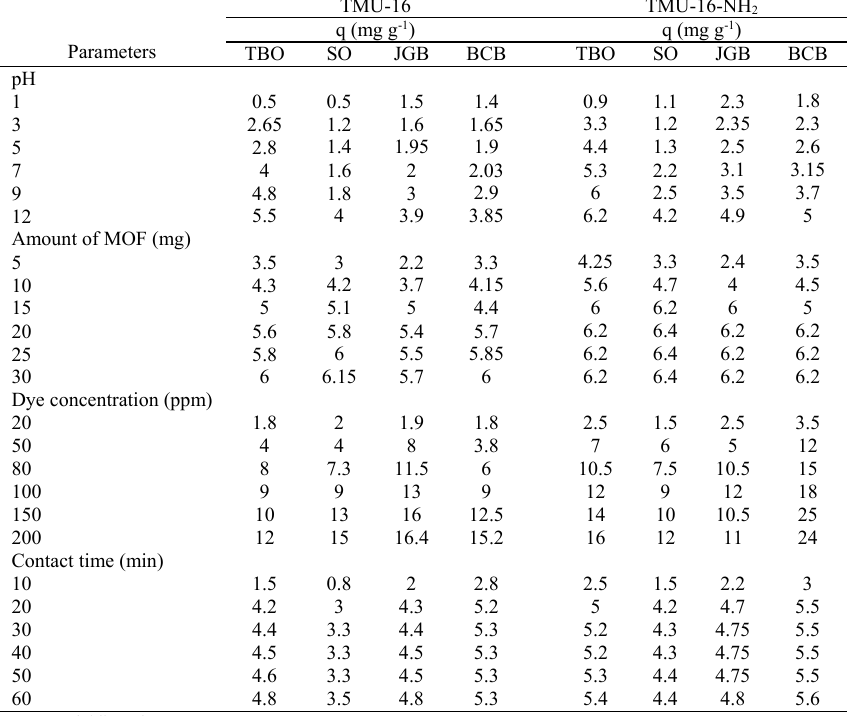
Table 1. Influence of various experimental parameters including pH, amount of MOF, dye concentration and contact time on adsorptive removal by TMU-16 and TMU-16-NH 2 .